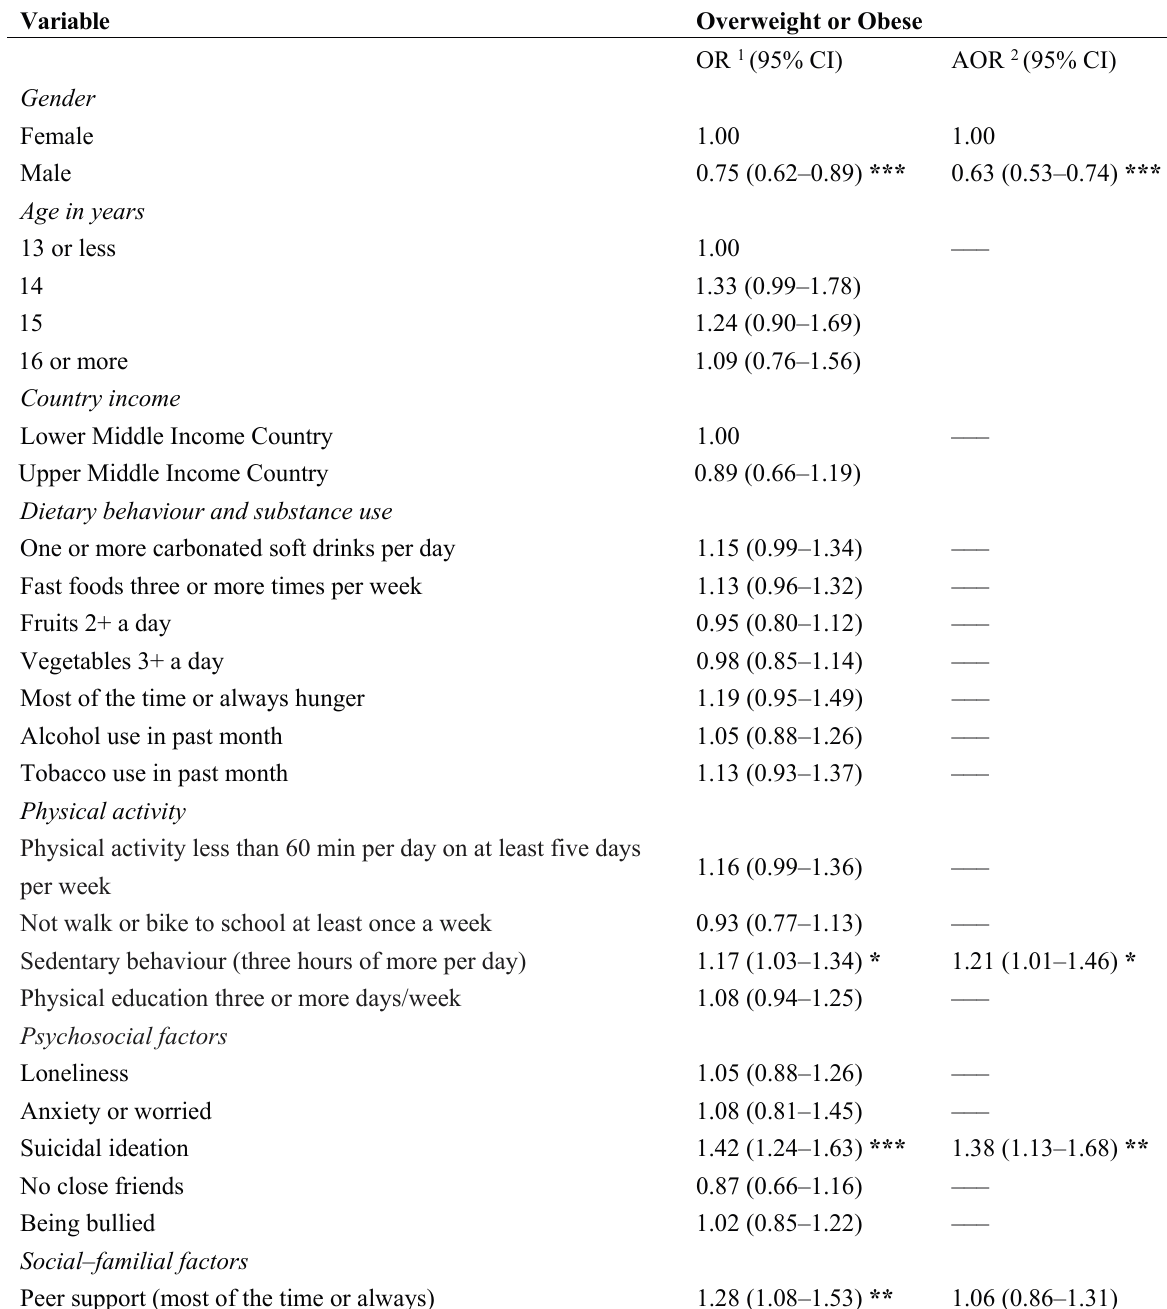
Table 3. Overweight or obesity regression